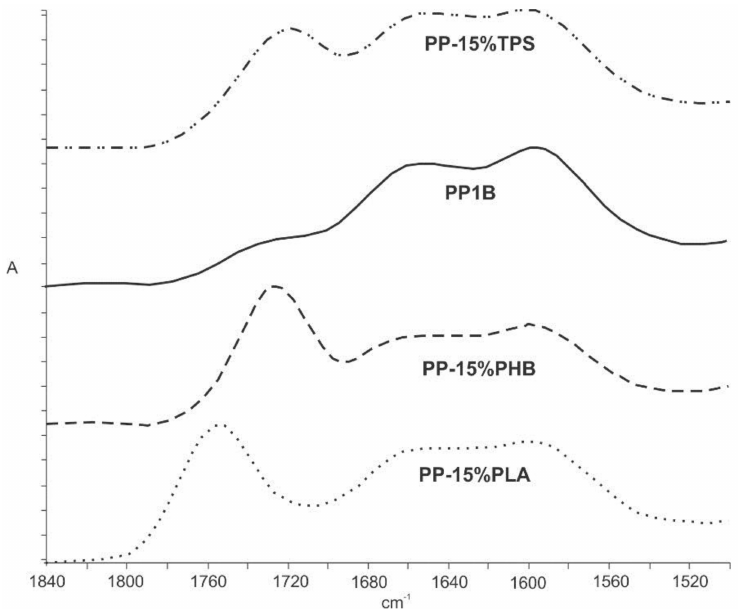
Figure 2. FTIR spectra: PP (PP1B) and PP with 15% biodegradable